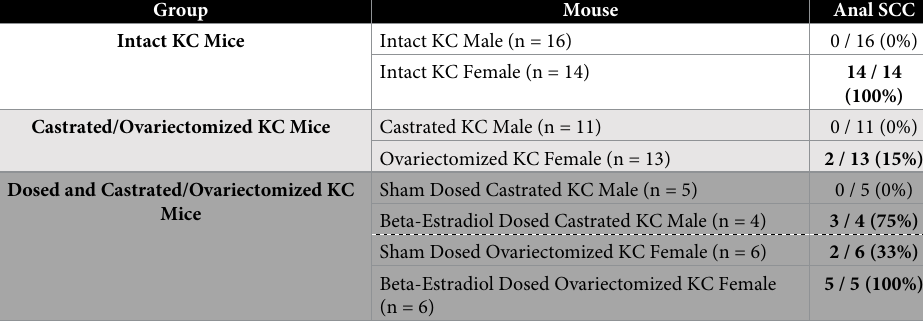
Table 3. Incidence of anal SCC in beta-estradiol dosed KC